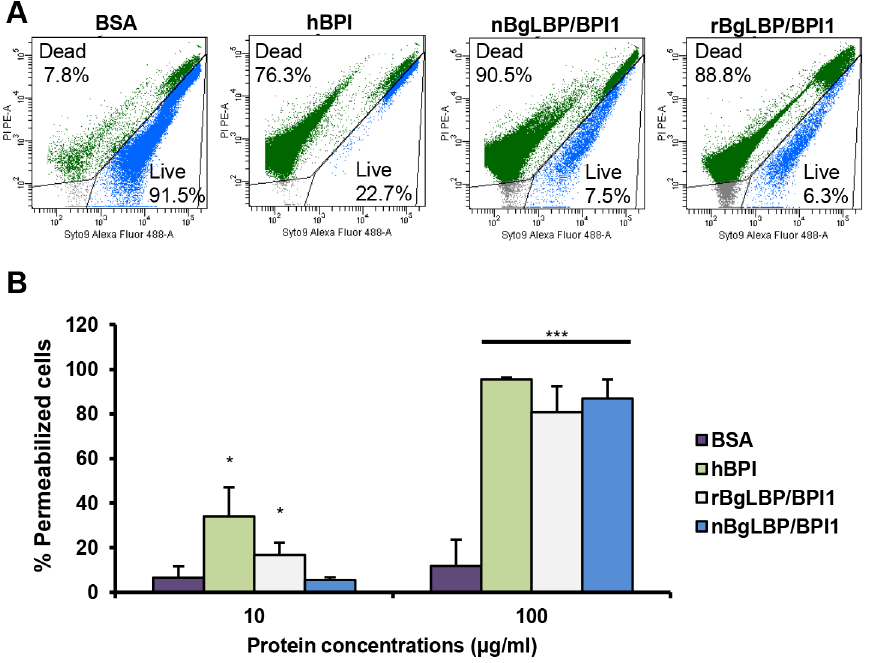
Figure 3. BgLBP/BPI1s permeabilize membranes and induce death of short LPS E.coli . (A) Representative flow cytometry profiles of E. coli SBS363 cells exposed to BSA (negative control), hBPI (positive control), native (n) BgLBP/BPI1 and recombinant (r) BgLBP/BPI1 at a concentration of 100 m g/ml, for 1 h. Cells have been stained with the Baclight kit (SYTO 9 and PI) and a total of 60,000 events were recorded for each sample. (B) Quantification of the effect of the four proteins on E. coli SBS363 cell death (as measured in (A)). Cell death has been measured by flow cytometry after 1 hour exposure to 10 or 100 m g/ml proteins. Results are the mean percentages of permeabilized cells 6 SE of three independent experiments. Asterisks indicate significant differences with negative control (*p , 0.05, ***p , 0.001).